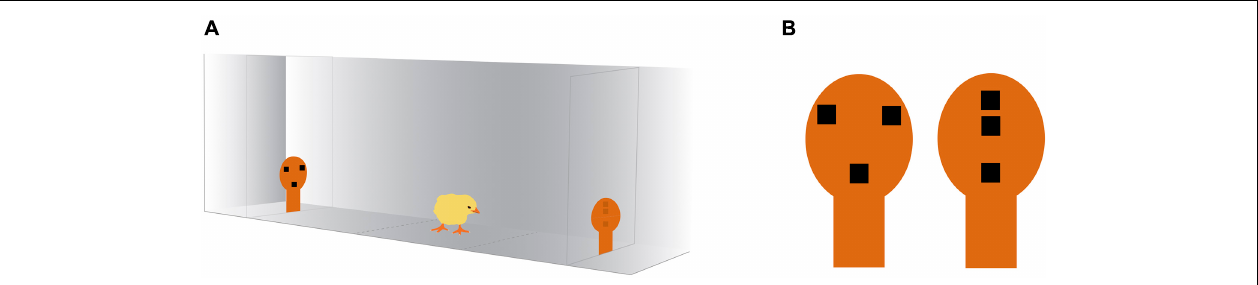
FIGURE 1 | Schematic illustration of the social preference test apparatus and the stimuli. (A) The chick was placed in the center of the arena and was free to approach either of the stimuli, placed at the two ends of the apparatus and lit by a 201 lumen LED. The chick’s behavior was video-recorded from above. (B) The stimuli consisted of orange stiff paper silhouettes containing internal features resembling a face-like configuration (left) or a non-social control configuration (right). The chick image is courtesy of Openclipart (openclipart.org) under Creative Commons Zero 1.0 Public Domain